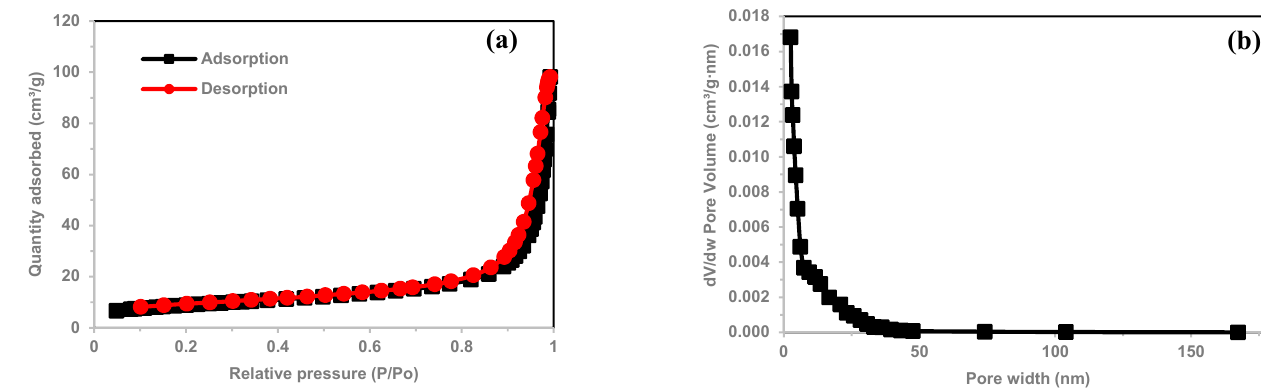
Figure 4. ( a ) N 2 adsorption/desorption isotherm and ( b ) pore size distribution curve of 2:1 inulin–TEOS hybrid adsorbent.